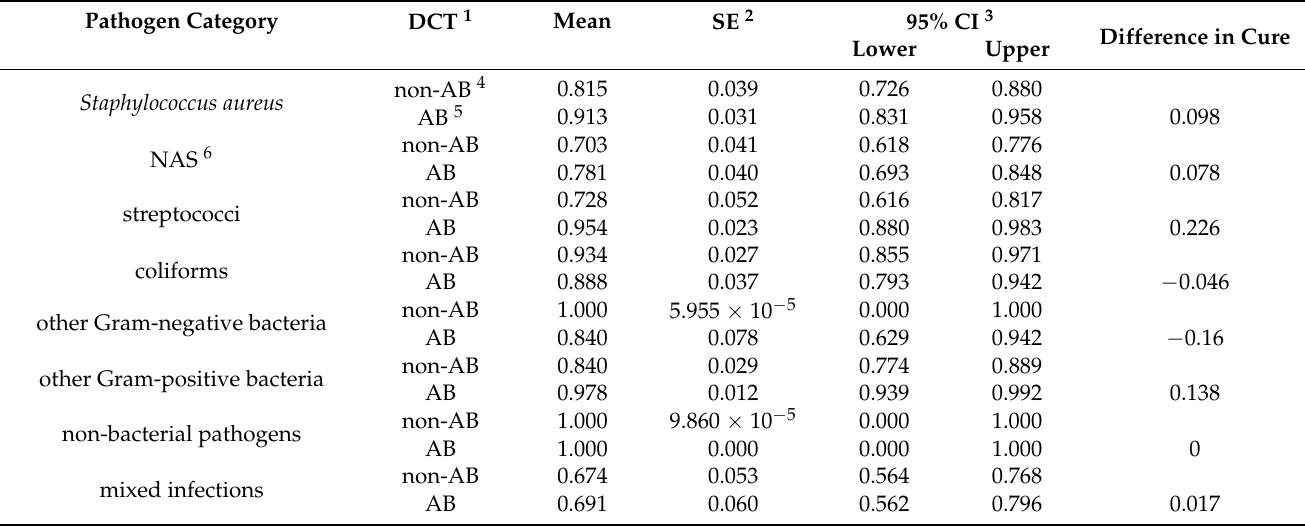
Table 4. Estimated means for the dry period cure of infected quarters treated with or without antibiotics at dry off for each pathogen